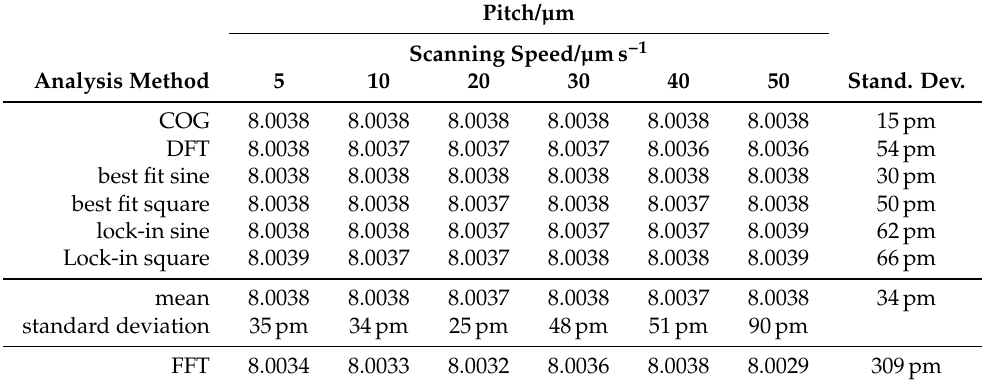
Table 2. Comparison of the calculated pitches for the different evaluation methods and the different scanning speeds. Values in a column should ideally be equal, as they are based on the same measuring data.